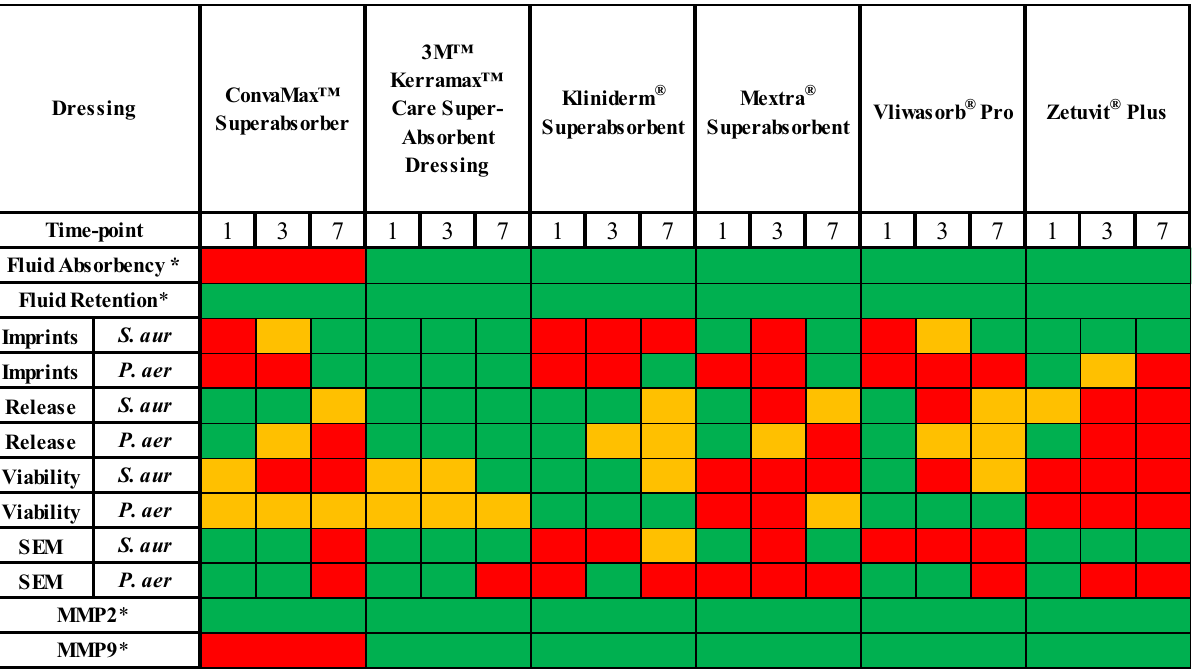
Table 2. Summary table of dressing performance. Green indicates comparatively good performance, amber indicates average performance and red indicates comparatively poor performance. *represents a single time